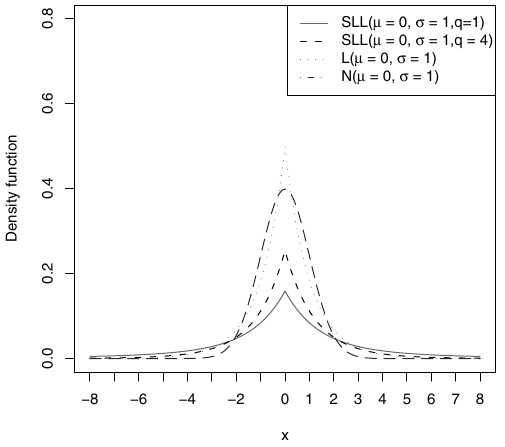
Figure 1 – Density functions for the univariate slash Laplace distribution for = 0 (cid:80) , =1 (cid:86) and for two values of q, along with standard normal and Laplace densities.